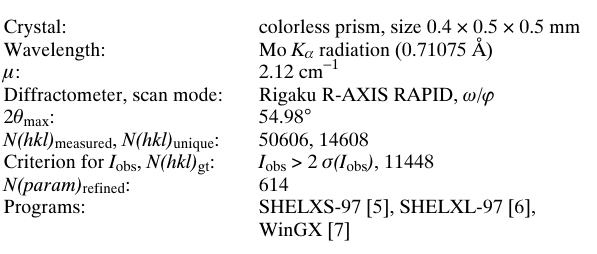
Table 1. Data collection and handling.